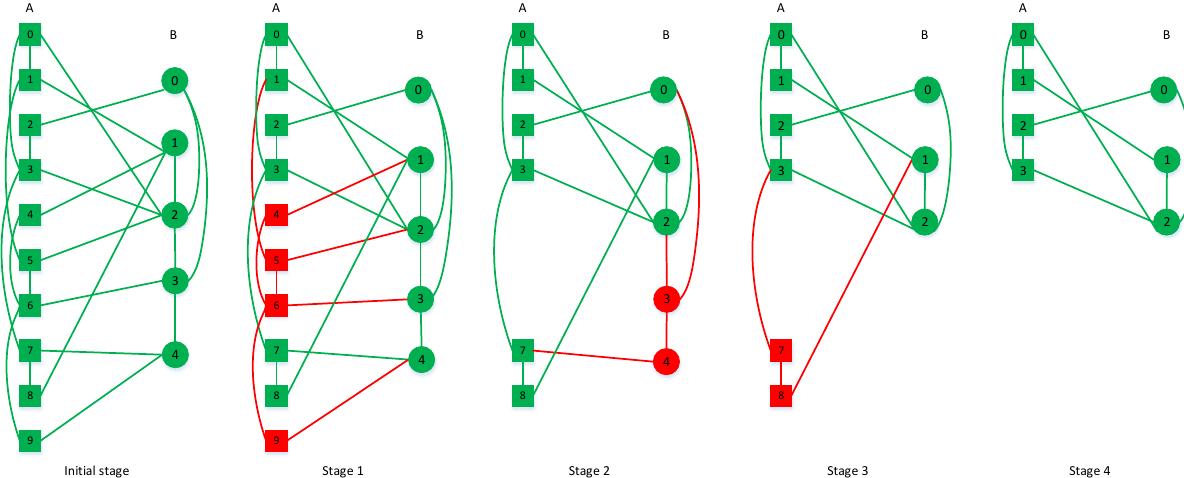
Figure 2. The processes of cascading failures in an interdependent network. Ten nodes and five nodes are in networks A and B . Node A 5 in the network A triggers the cascading failure of the entire system. At stage 1, all links with node A 5 are failed and removed. Thus, node A 4 , A 6 , and A 9 are disconnected from the giant component in the network A . At the second stage, node A 4 , A 6 , and A 9 have removed all links. Node B 3 loses supporting links from network A and B 4 is excluded from the giant component. Thus, these two nodes fail. All nodes B 3 , B 4 and their links are deleted in stage 3. Then, the network B splits. Node A 7 fails as it loses its dependent nodes. Node A 8 fails since it is part of the giant component. In the final stage, the cascading failure stops propagating on this model. Only several nodes can operate